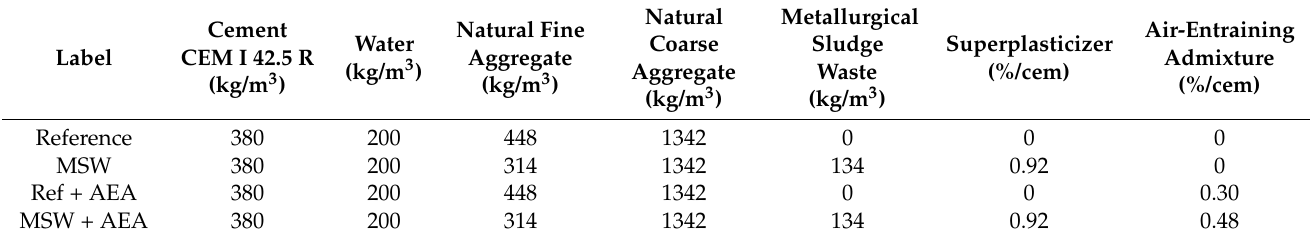
Table 2. Composition of concrete